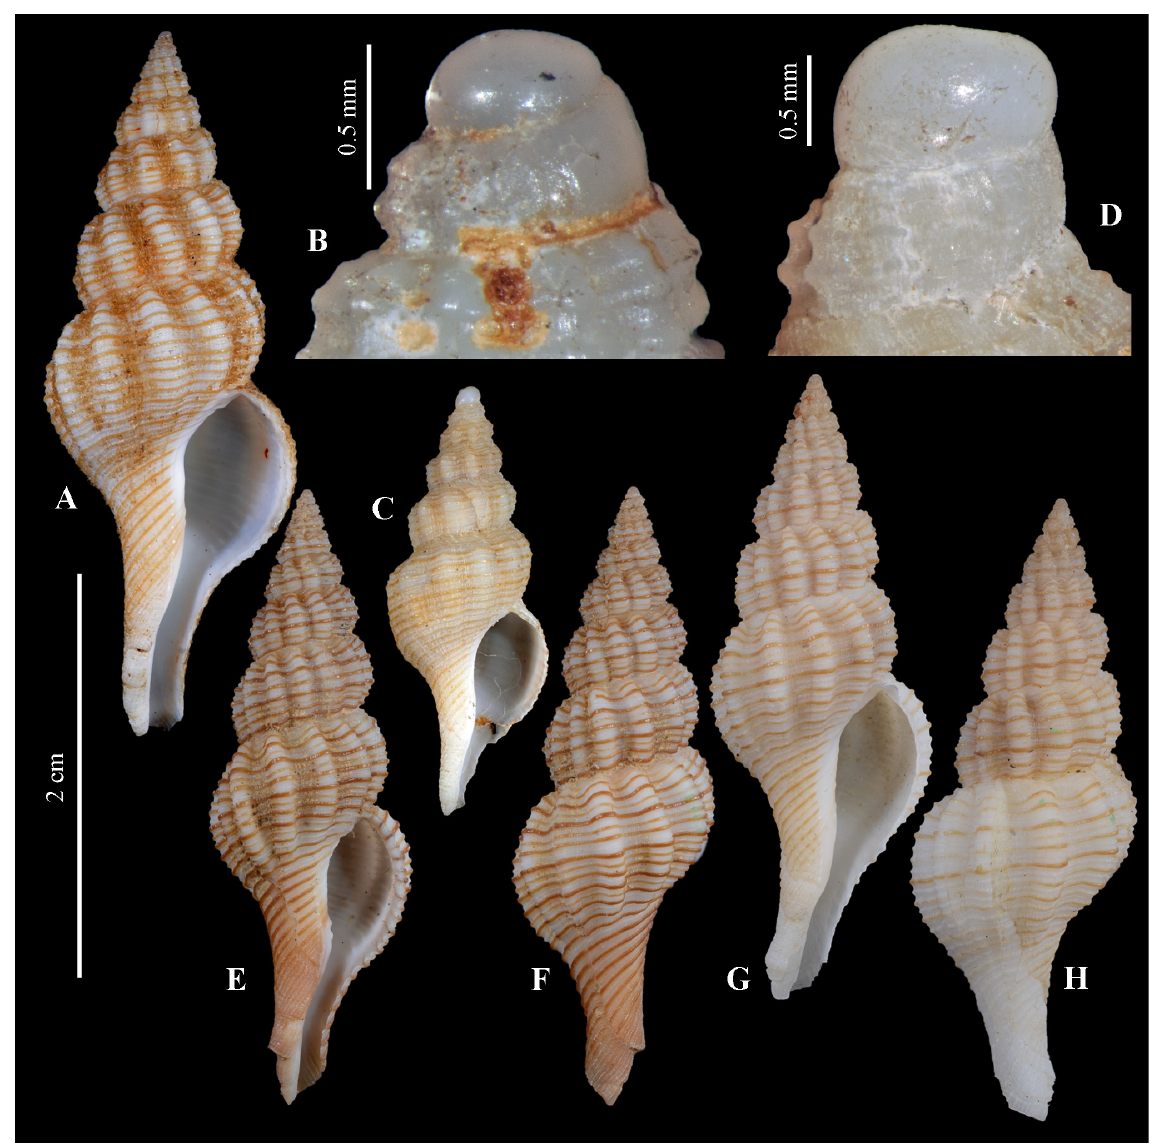
Fig. 8. A–B . Granulifusus kurodai (Okutani & Sakurai, 1964) comb. nov., paratype 1, SL 35.1 mm (NSMT-Mo58524). C–D . Fusolatirus sp. aff. luteus Snyder & Bouchet, 2006 (paratype 3